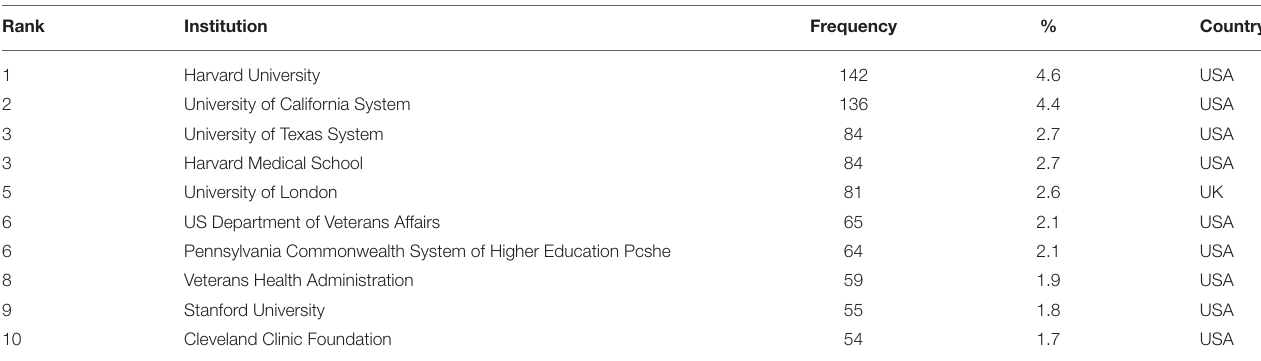
TABLE 2 | The institutions contributing the most gender-related articles in medical artificial intelligence.